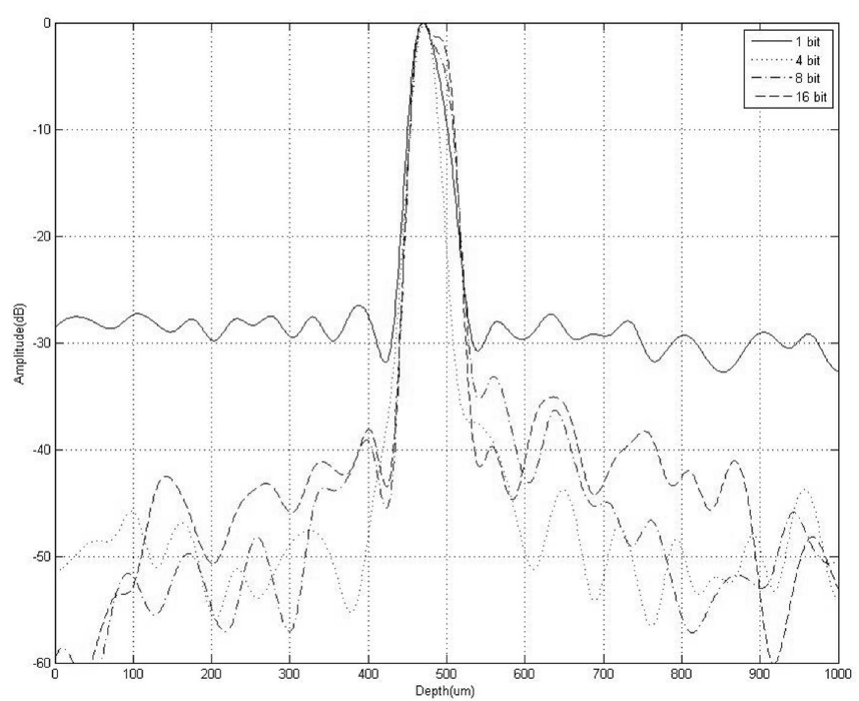
Figure 4. Envelope of decoded echo